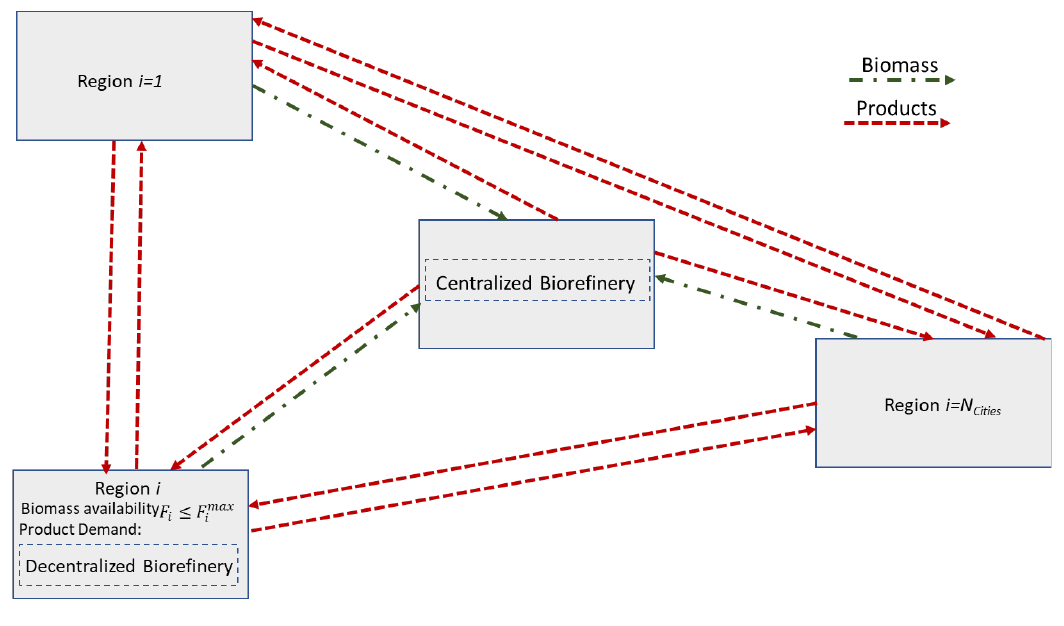
Figure 2. Superstructure of centralized and decentralized biorefining options.